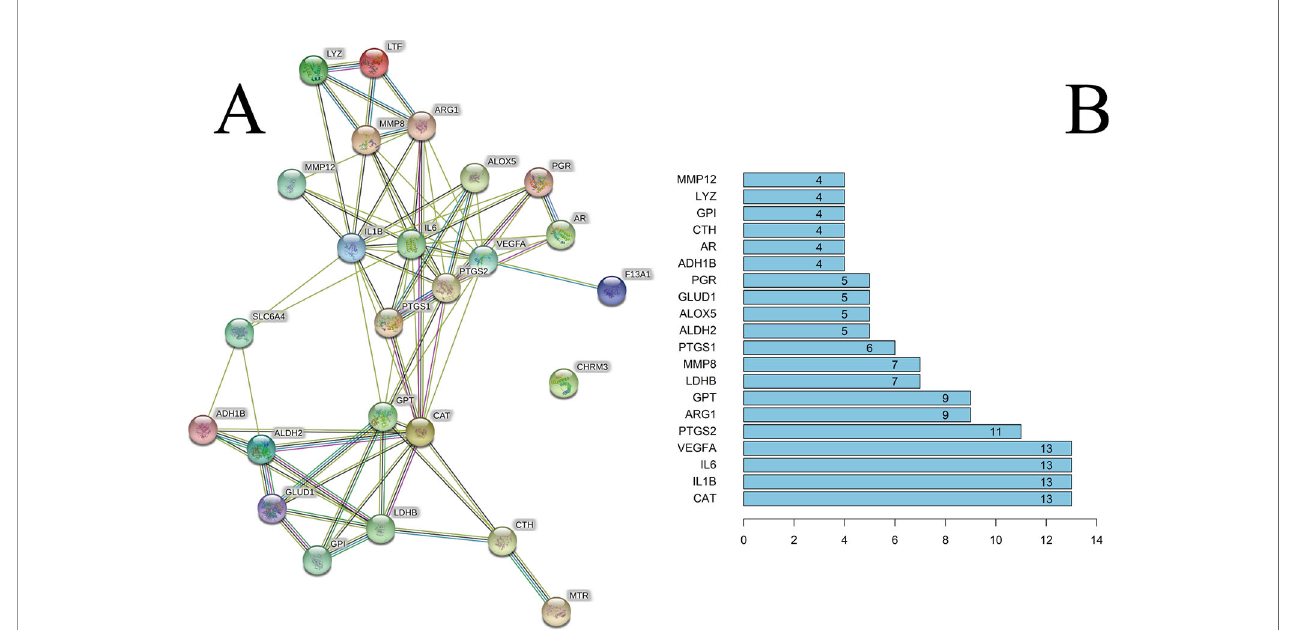
FIGURE 3 | (A) The PPI network. (B) The bar plot of the PPI network. The x-axis represents the number of neighboring proteins of the target protein. The y-axis represents the target